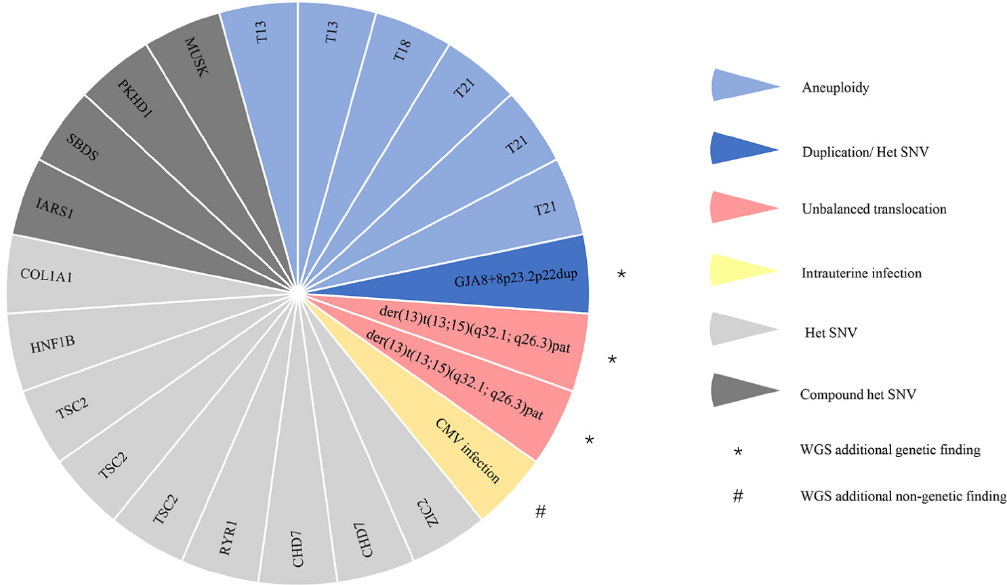
Figure 2. Architecture of a mixed cohort referred for prenatal diagnosis. Each slice of the pie chart represents one individual in the prospective cases analyzed by genome sequencing (WGS) and chromosomal microarray (CMA) plus exome sequencing (WES) where clinically relevant findings were identified. Types of variant are indicated by colors (aneuploidy, light blue; duplication and heterozygous (het) single nucleotide variant (SNV), blue; unbalanced translocation, red; intrauterine infection, yellow; compound heterozygous SNV, light gray; heterozygous SNV, dark gray). Additional genetic findings by WGS are indicated by * and additional nongenetic findings by WGS are indicated by #.